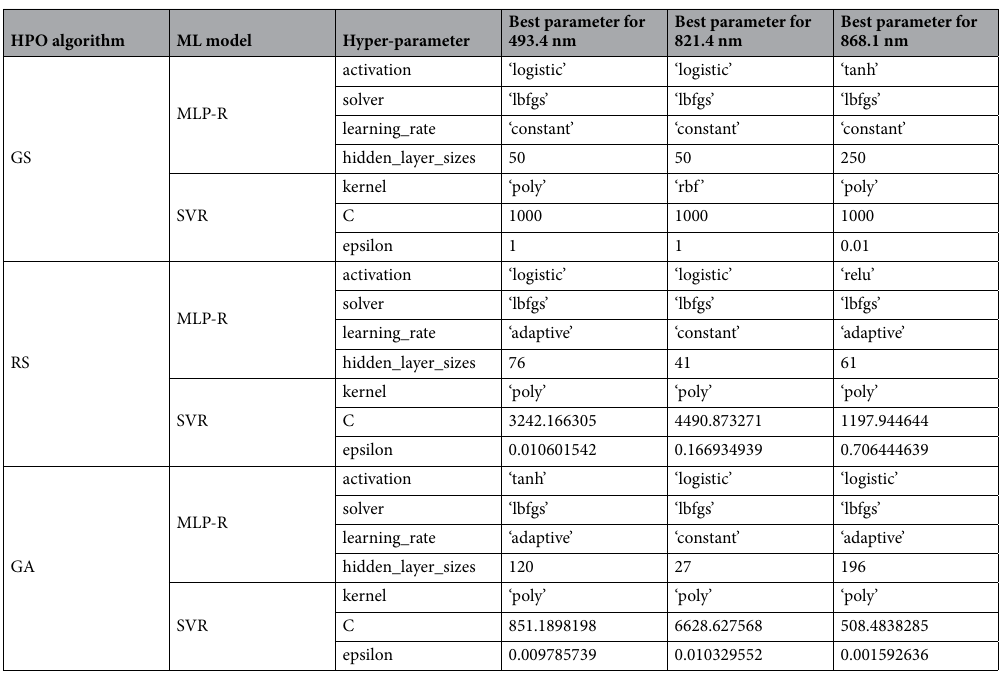
Table 3. Optimal hyper-parameter configuration selected by different HPO algorithms at different